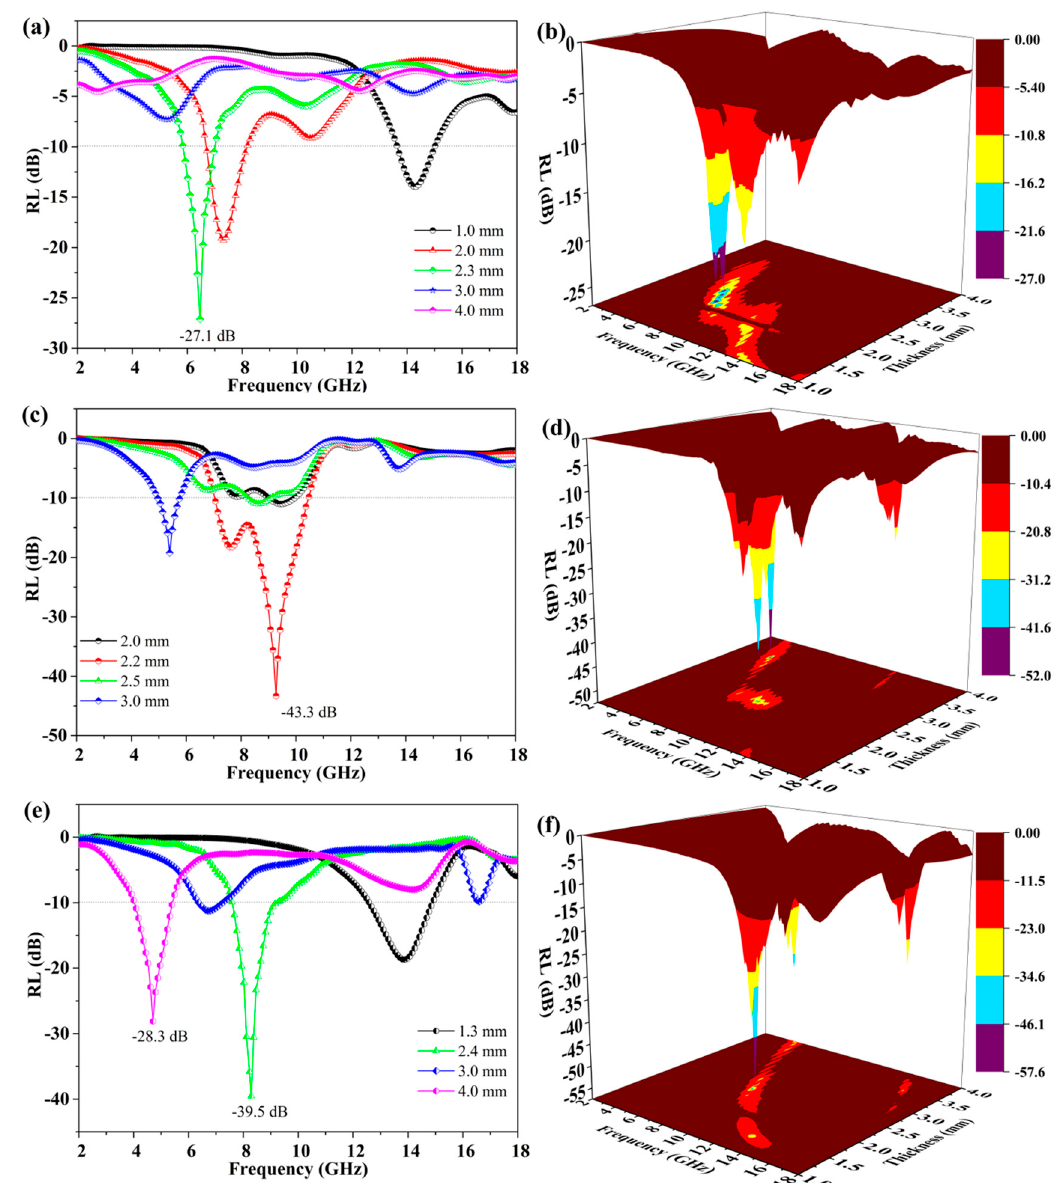
Figure 7. RL and 3D surface plots of GNPs@Ni x S y @MoS 2 -1 composite ( a, b ), GNPs@Ni x S y @MoS 2 -2